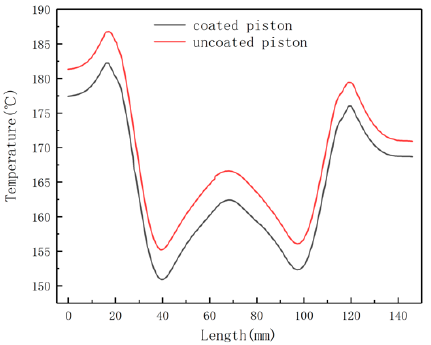
Figure 15. The temperature distribution along the AB path. Red indicates the temperature of the uncoated piston substrate, and black indicates the temperature of the piston substrate after spraying the coating.